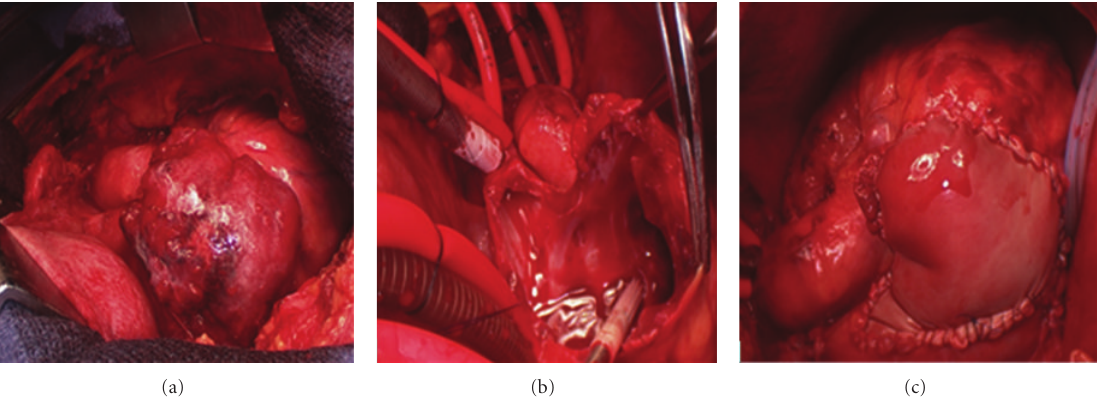
Figure 2: Intraoperative photos of identification (a), excision (b), and reconstruction (c) of the right atrial